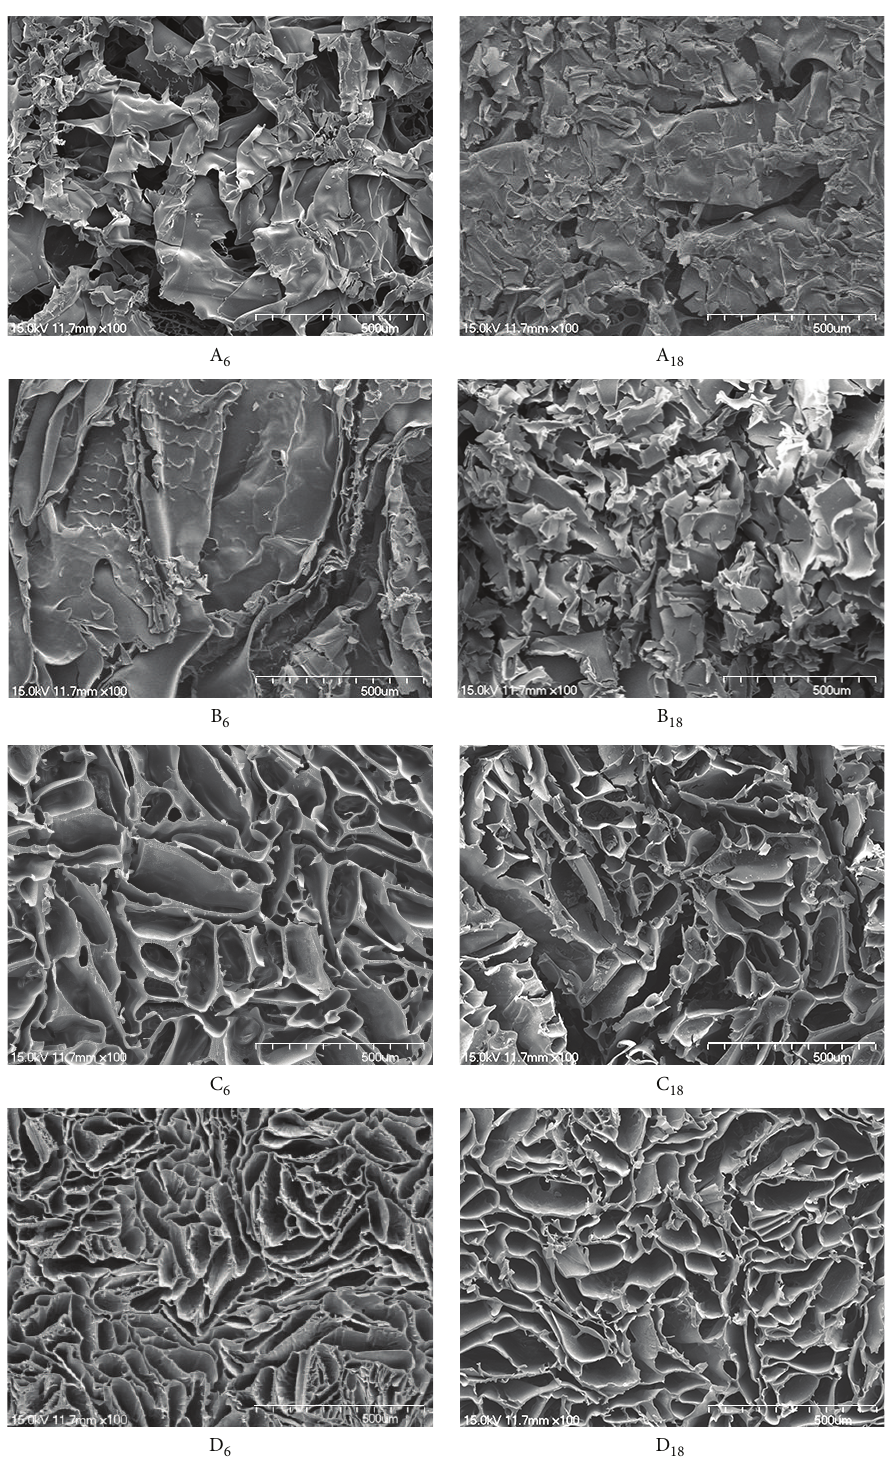
Figure 4: SEM images of four groups of porous silk fibroin scaffolds after degradation by collagenase IA for 6 days (A 6 , B 6 , C 6 , and D 6 ) and 18 days (A 18 , B 18 , C 18 , and D 18 ) (scale bar: 500 𝜇